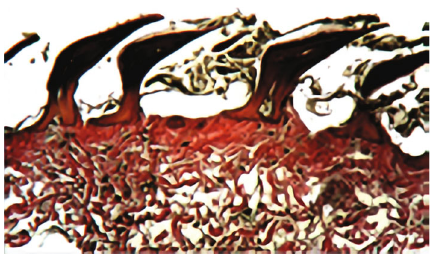
Figure 1: Histological section of shark